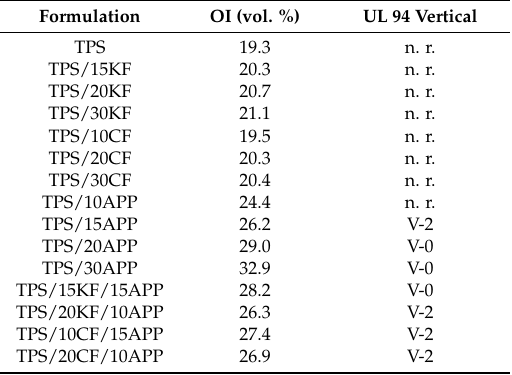
Table 4. OI and UL 94 vertical test results of investigated biocomposites; no vertical rating (n.